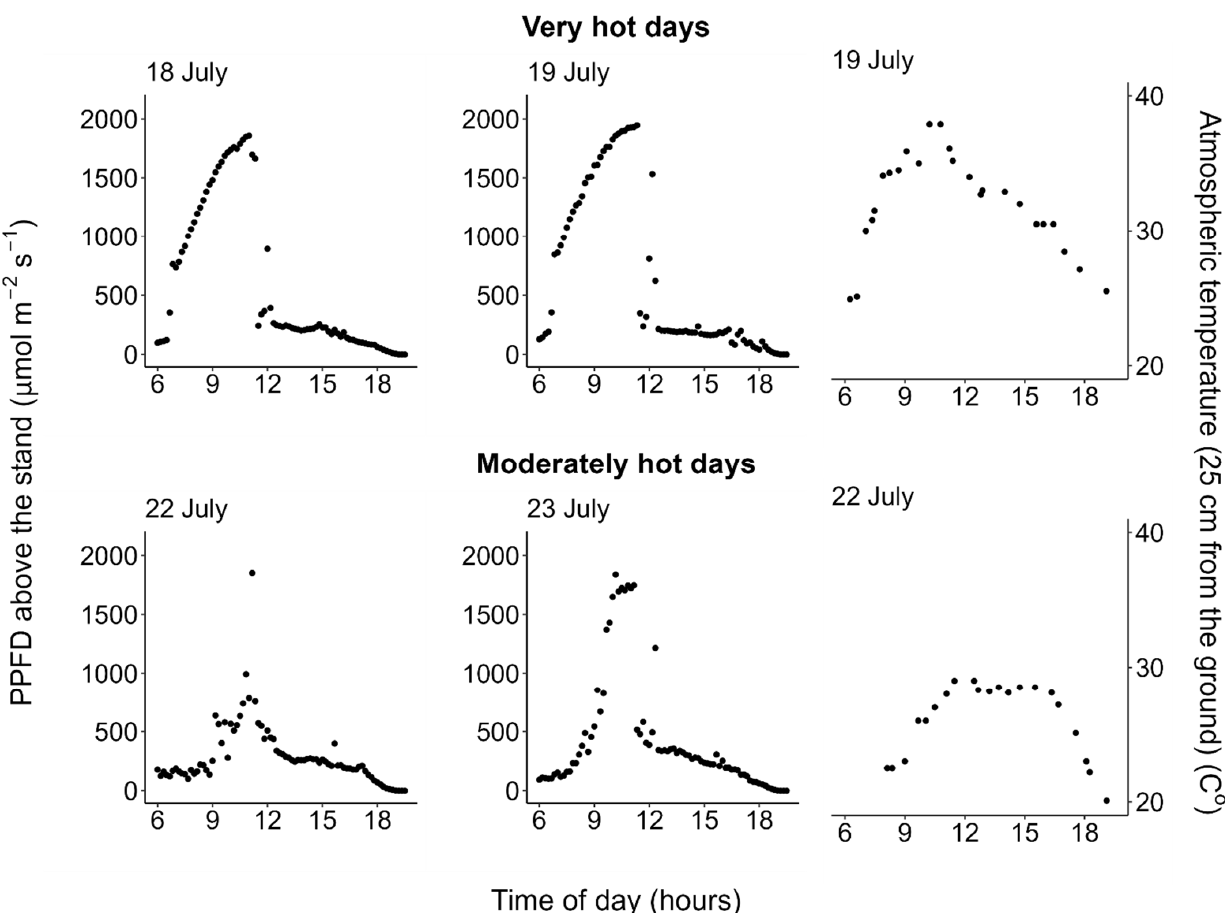
Figure 1. Diurnal courses of photosynthetic photon flux density (PPFD) incident on the horizontal surface above the Menyanthes trifoliata stand, measured at the height of 2 m from the ground, and of atmospheric temperature measured at the position of the approximate height of the leaves (0.25 m from the ground). Note that even on the hot clear sunny days, incident PPFD above the stand declined in the afternoons because of shading by the trees at the pond shore. All data are available in the Supplementary Materials.